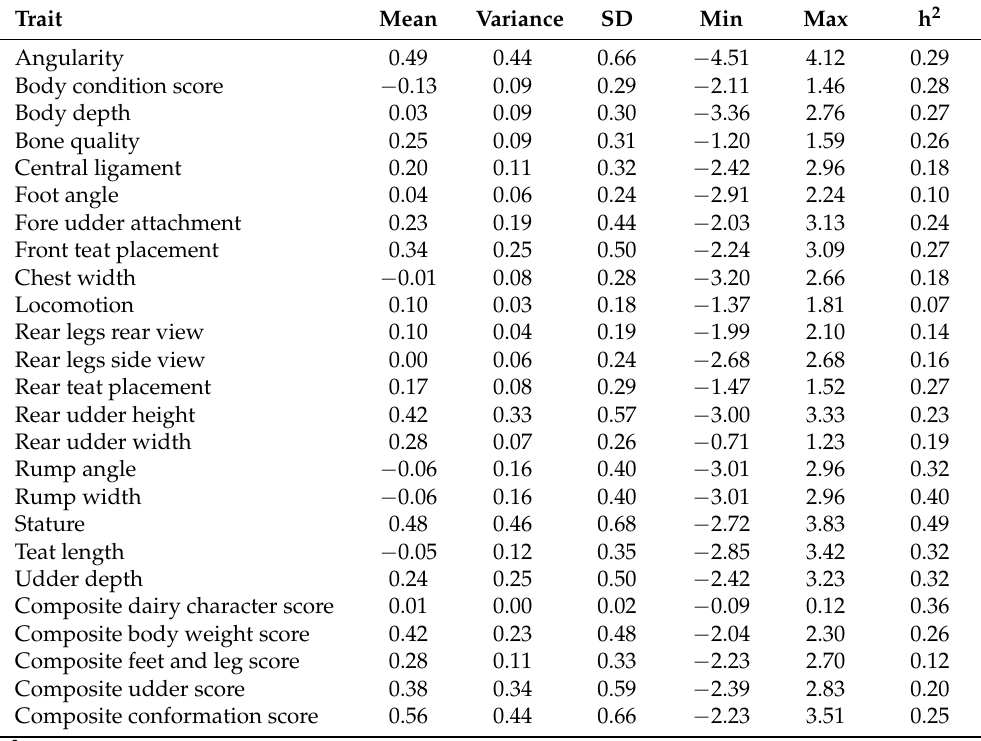
Table 2. Descriptive statistics of genomic breeding values (N = 1,772,297) for 25 linear type traits.